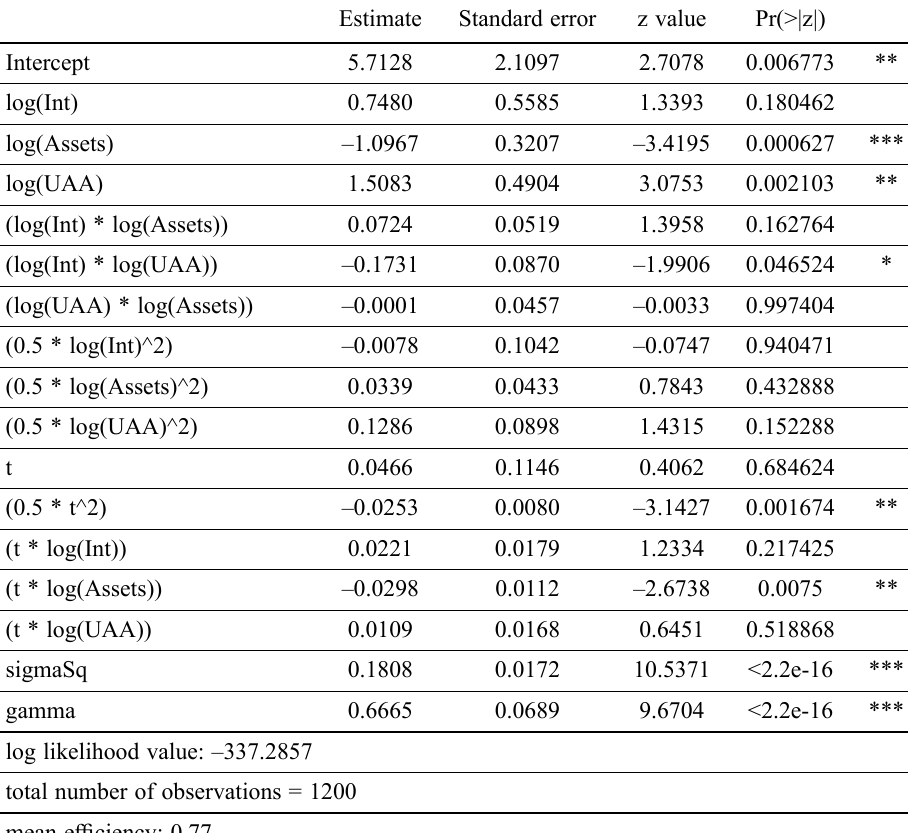
Table 2. The estimated stochastic production frontier for the Lithuanian family farms (2004–2009)